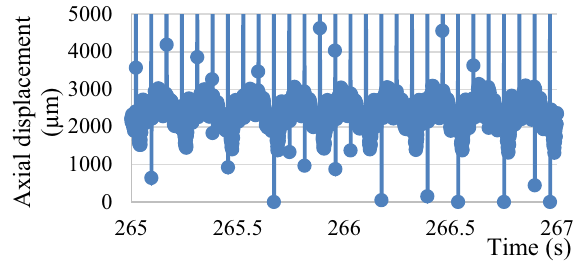
Fig. 22 Kick effects on rotary speed—no-kick region #2 for